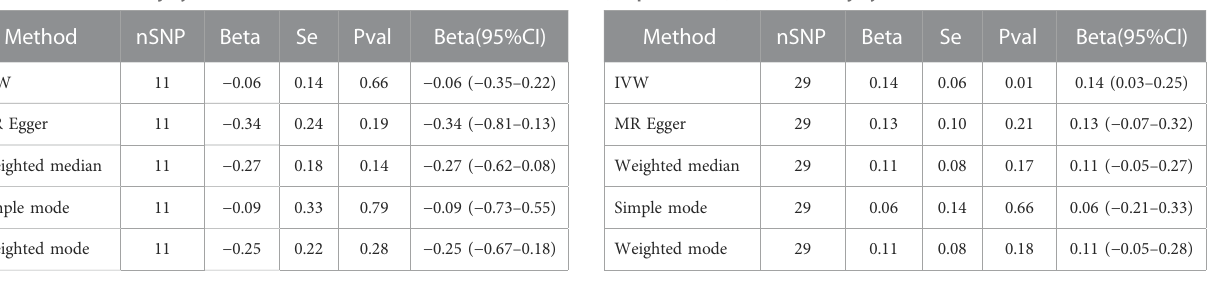
TABLE 2 Mendelian randomization analysis between COVID-19 severity (hospitalization) and cardiac injury